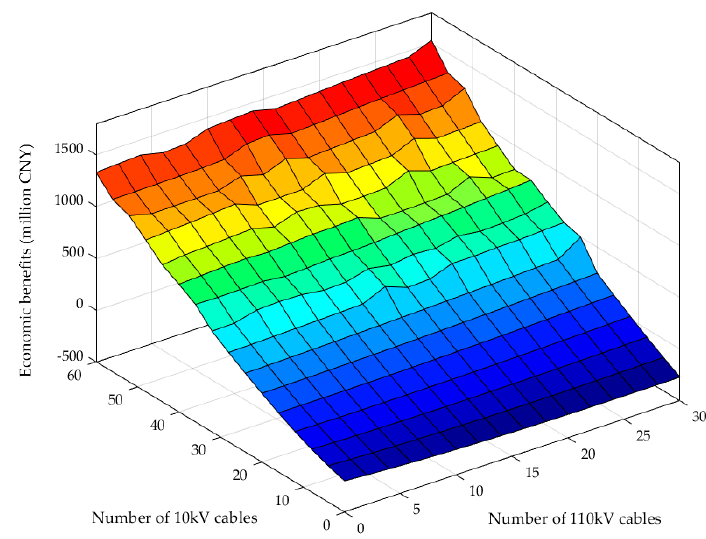
Figure 8. The relationship between the number of cables and the economic benefits.